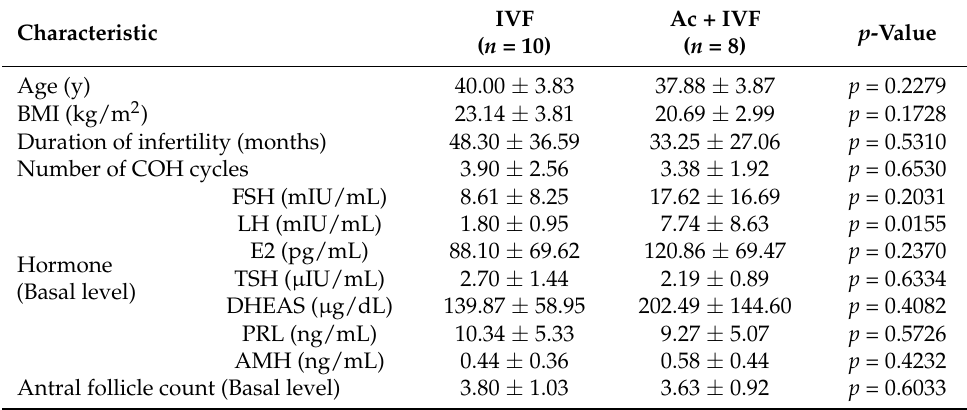
Table 3. Clinical characteristics of patients enrolled in the two study groups.